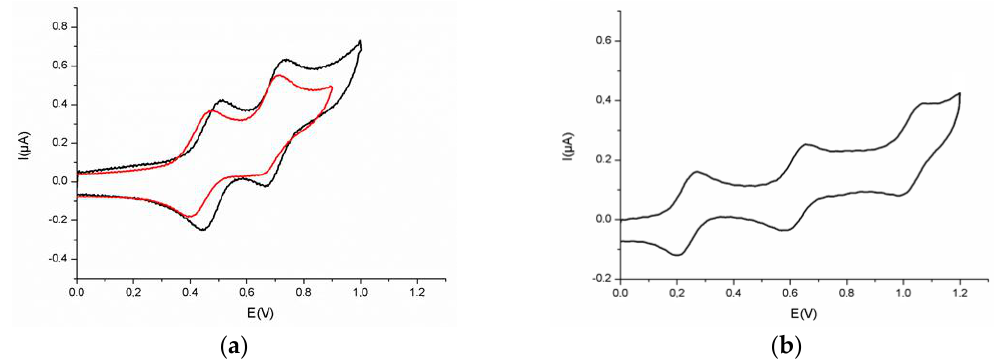
Figure 3. CV of ( a ) trans -[Hg(C≡CMe 3 TTF) 2 ] 5 (red curve) and trans -[Hg(C≡C–C≡CMe 3 TTF) 2 ] 6 (black curve) in DMF, ( b ) trans -[RuCl(C≡C–C≡CMe 3 TTF)(dppe) 2 ] 9 in CH 2 Cl 2 , with NBu 4 PF 6 0.1 M, E vs. SCE.